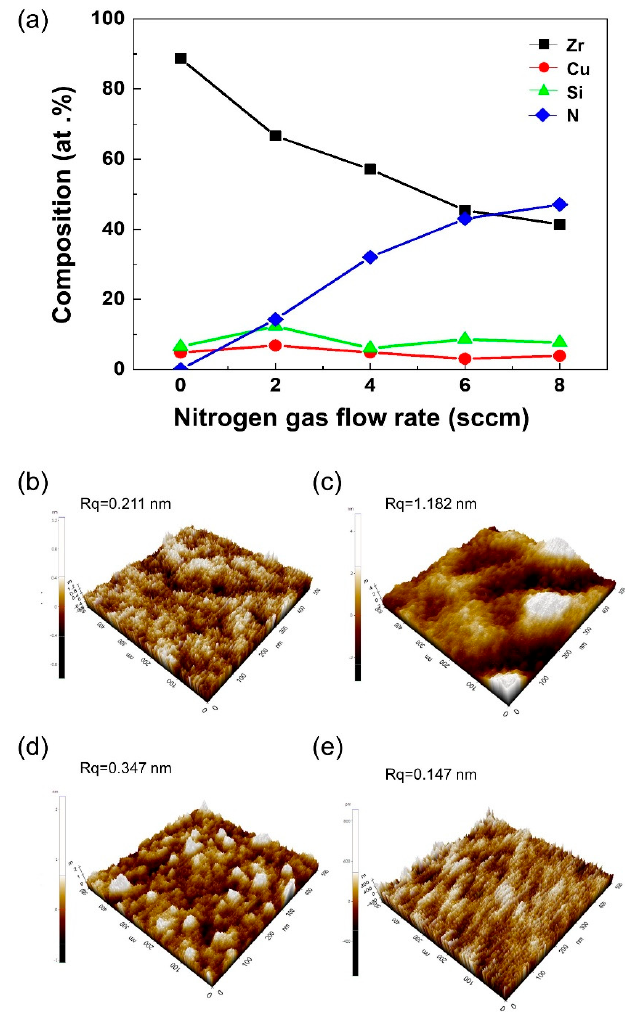
Figure 2. ( a ) Composition of ZrCuSiN coatings deposited at different N 2 gas flows. ( b ), ( e ) 3D AFM images of the ZrCuSiN coatings deposited at different nitrogen gas flows: ( b ) 2 sccm, ( c ) 4 sccm, ( d ) 6 ( d ) 6 sccm, and ( e ) 8 sccm, and ( e ) 8 sccm.